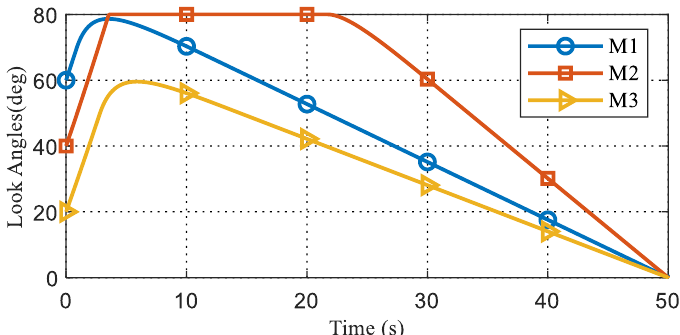
Figure 13. Look angles in a salvo attack.